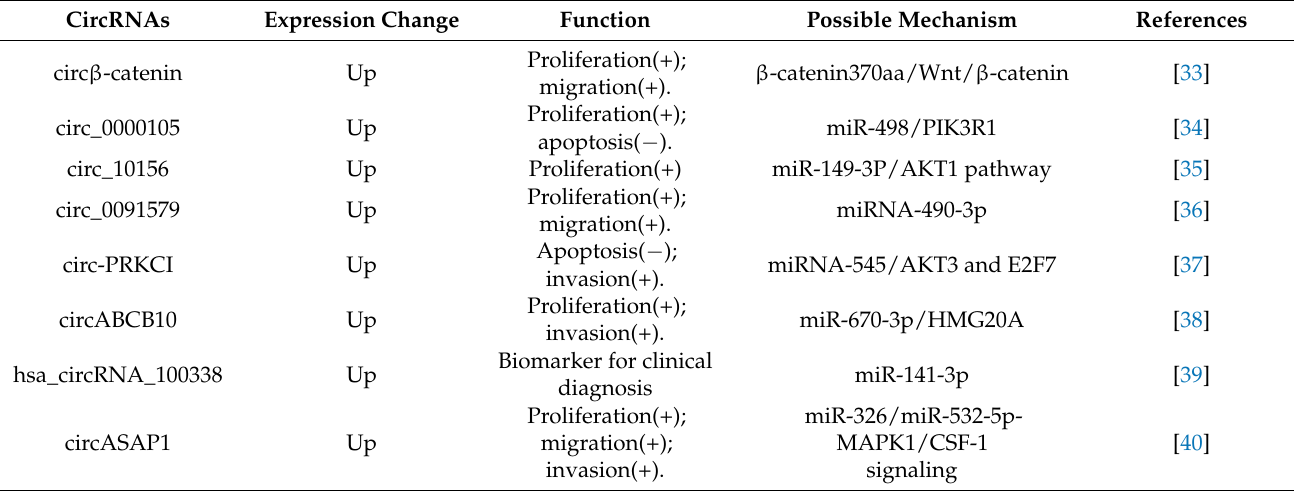
Table 2. Expression and Function of carcinogenic circRNA in